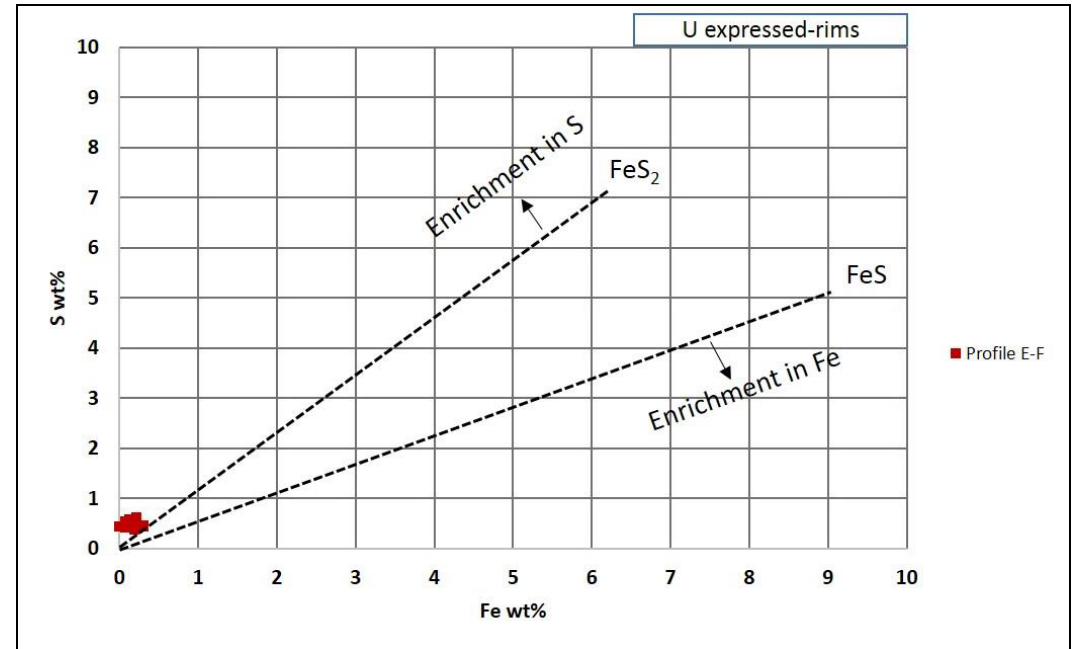
Figure 12. EPMA S and Fe concentration measurements of profile E-F performed on a telohuminite particle (ulminite). Both S and Fe are always below 1 wt %, with a slight enrichment in S. Reference lines refer to the stoichiometry of FeS 2 (pyrite) and FeS (i.e., mackinawite).